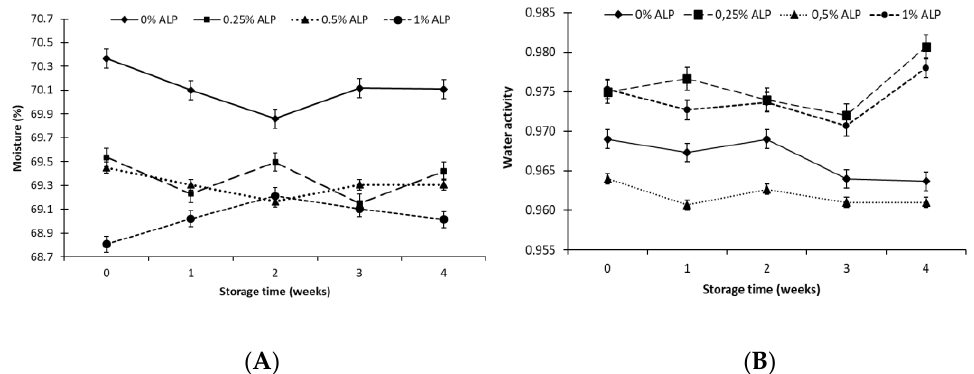
Figure 2. Moisture content ( A ) and water activity ( B ) in acid curd cheese with different addition (0 – 1%) of astaxanthin lipid preparation (ALP) during 4 weeks of refrigerated storage (5 ± 1 °C). Changes in water activity (a w ) of the test samples during storage were not statistically significant (Table 1). However, a w was significantly affected by the addition of ALP. Cheese with 0.25% ALP had the highest average water activity of 0.25% (a w = 0.976), followed by ALP 1% (0.974), a control sample (0.967) and ALP 0.5% (0.962) (Figure 2B). Similar water activity values of tvarog were shown by Godula et al. [41], who did not report any significant change in a w during storage stability studies of traditional and lactose-free acid curd cheese. Water isms and depends on, for example, salt content, binding of water by food components, as well as acidity [42,43]. Water activity affecting shelf-life, fat oxidation, protein denatura- tion, and vitamin degradation. Alla El-Bialy and Abd El-Khalek [44] found that the addi- tion of astaxanthin preparations to tilapia meat reduced a w by 0.05 and this effect was